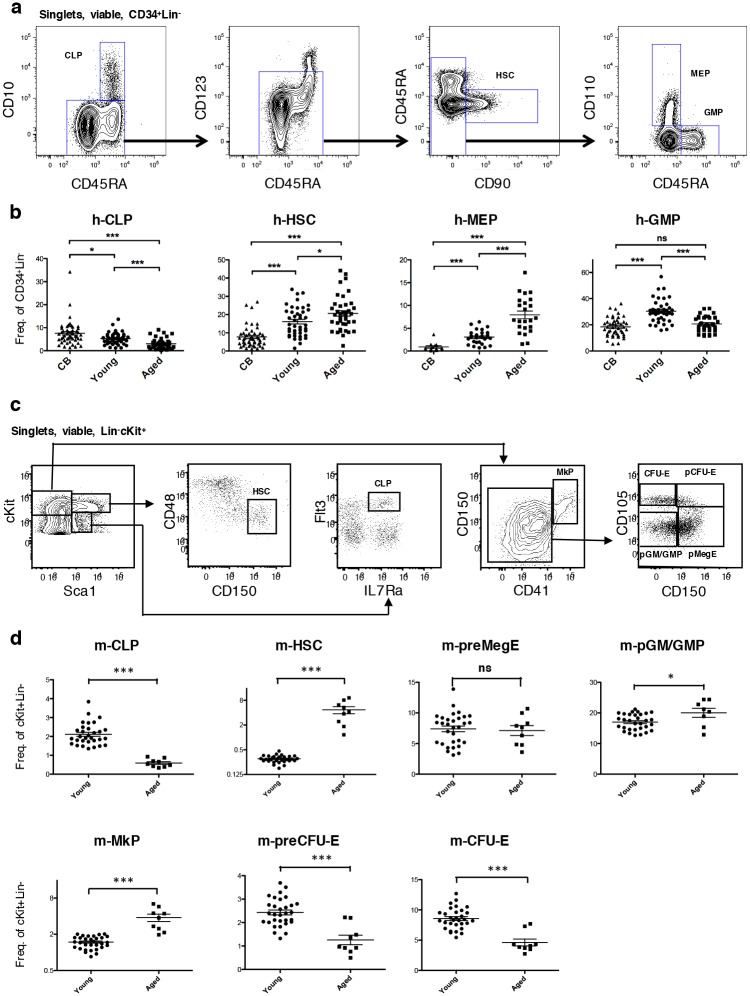
Frequencies of human and murine hematopoietic stem and progenitor cells at different ontogenic stages.(A-B) Gating strategy and HSPC frequencies for human donors.
(A) Flow cytometric profile and gating strategy for h-CLPs (CD10+CD45RA+), h-HSCs (CD123low/-CD45RA-CD90+), h-MEPs (CD123low/-CD45RA-CD110+) and h-GMPs (CD123low/-CD45RA+) in one aged bone marrow sample. Pre-gated on viable CD34+Lin- singlets. (B) Frequencies of depicted early hematopoietic cell types within the primitive CD34+Lin- fraction. Each point represents one donor. H-HSCs: aged n = 44, young n = 52, CB n = 58. H-GMPs: aged n = 42, young n = 52, CB n = 45. H-MEPs: aged n = 29, young n = 46, CB n = 13. H-CLPs: aged n = 42, young n = 52, CB n = 49. (C-D) Gating strategy and HSPC frequencies for mouse donors.
(C) Flow cytometric profile and gating strategy for m-HSCs (Sca1+KithighCD150+CD48-), m-CLPs (Sca1+/-cKitlowFlt3+IL7Ra+), m-MkPs (Sca1-cKithighCD150+CD41+), m-pGM/GMPs (Sca1-cKithighCD41-CD150-CD105-), m-pMegEs (Sca1-cKithighCD41-CD150+CD105-), m-pCFU-Es (Sca1-cKithighCD41-CD150+CD105+) and CFU-Es (Sca1-cKithighCD41-CD150-CD105+) in one old murine bone marrow sample. Pre-gated on viable cKit+Lin- singlets. (D) Frequencies of depicted early hematopoietic cell types within the primitive Lin-cKit+ fraction. Each point represents one donor. Young n = 31, aged n = 9. Analyses were performed with unpaired t-tests. * p ≤ 0.05, ** p ≤ 0.01, *** p ≤ 0.001. Reference lines depict means ± SEM.